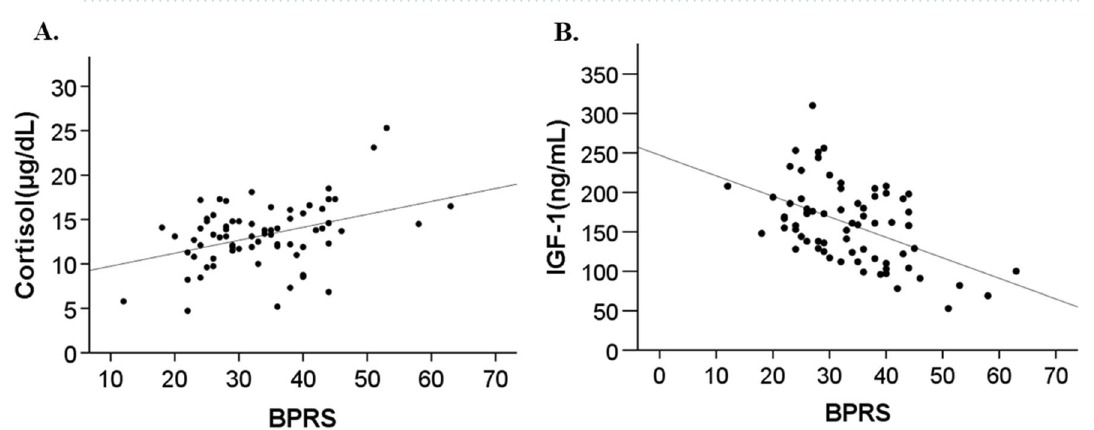
Figure 2. Scatterplots of serum cortisol level versus Hamilton Depression Rating Scale (HAM-D) score ( A ) and serum insulin-like growth factor (IGF)-1 level versus HAM-D score ( B ) in patients with major depressive disorder. Serum cortisol level was significantly positively correlated with HAM-D score (R = 0.28, p < 0.01) ( A ), and serum IGF-1 level was significantly positively correlated with HAM-D score (R = 0.24, p < 0.01) ( B ).